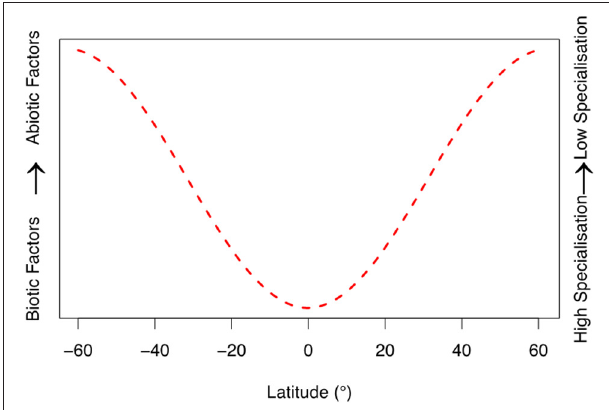
FIGURE 1 | Qualitative conceptual model based of our reviews developed hypotheses. Specificity of fungal entomopathogenic communities’ changes with latitude, corresponding to biotic and abiotic factors. Biotic factors are related to interactions with the host and other microbes (i.e., coevolutionary arms races and infection pathways). Abiotic factors include environmental variables such as temperature, humidity, UV radiation, and oxidative and osmotic stressors. The latitudinal range was capped at 60 ◦ N and 60 ◦ S, as this figure does not account for the climatic extremes beyond these thresholds on fungal communities. We hypothesize that at lower latitudes entomopathogenic fungi inhabit more ideal environmental conditions, despite increased pressure from other fungal species, and greater host defense (see “Abiotic conditions and adaptation” and “Biotic interactions and adaptation” sections of main text for more information). This corresponds to an increase in specialization of entomopathogenic